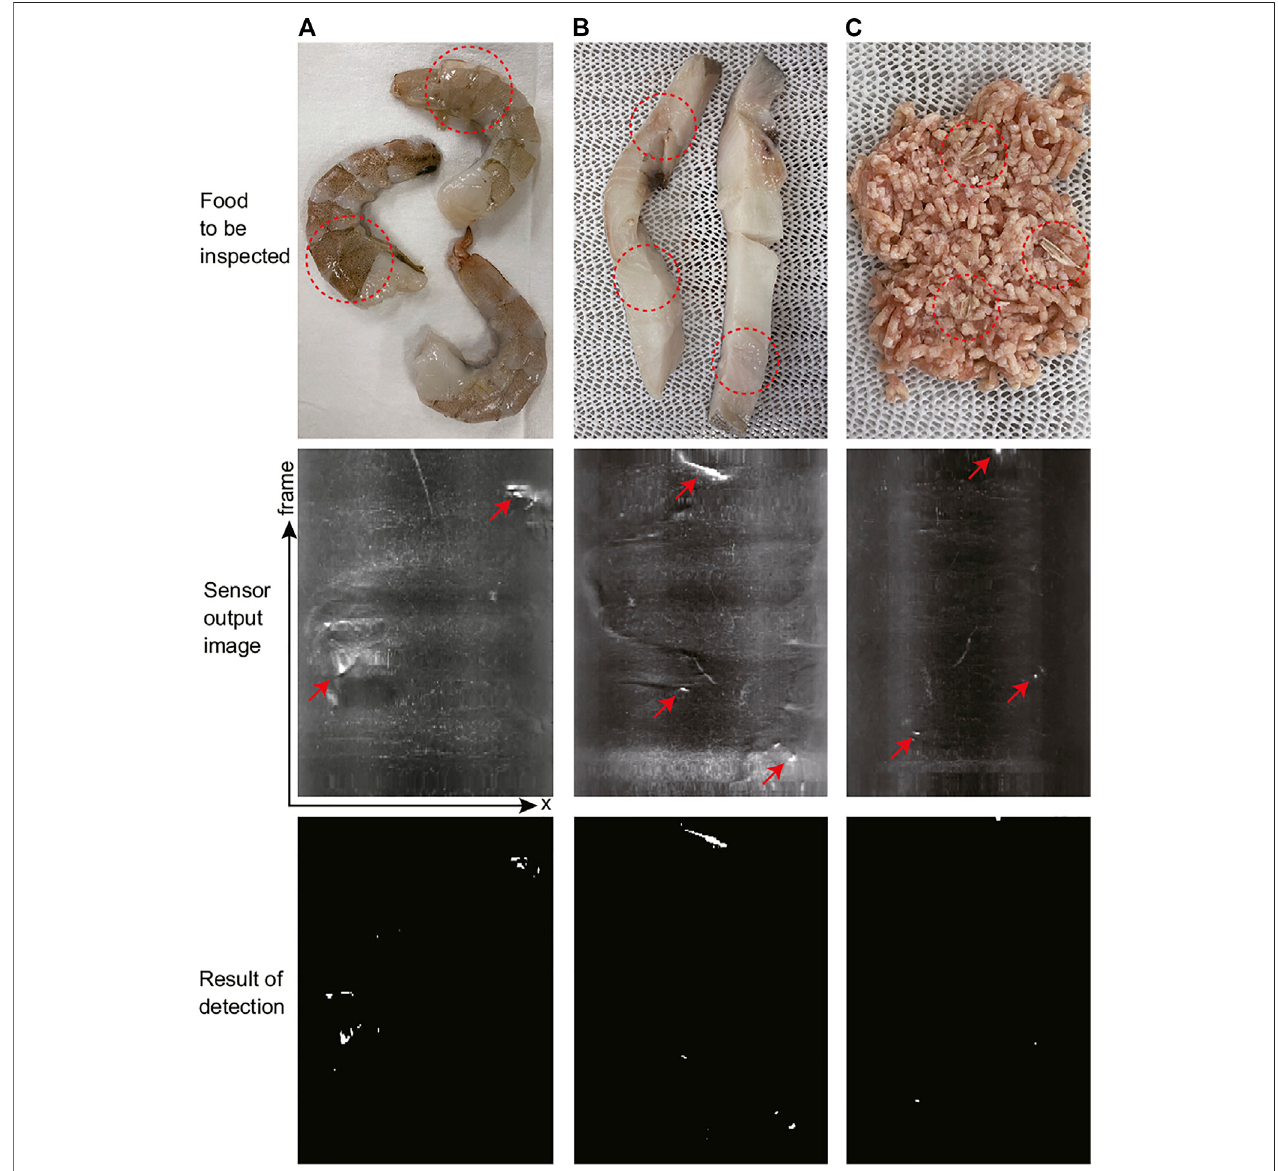
FIGURE 10 | Experimental results for foods. (A) raw shrimp, (B) raw fi sh fi llet, and (C) minced chicken. From top to down, photo of the real foods, raw output images from the tactile image sensor ( x − t image obtained by stacking single line extracted from each frame), and results of foreign bodies detection (binarized image).